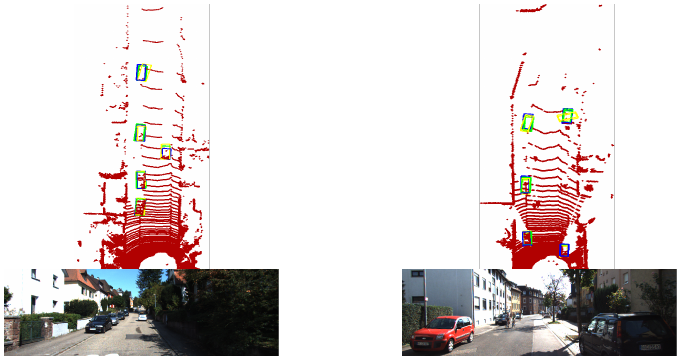
Figure 8. The qualitative results for orientation error. For better visualization, we put the results of the original network and proposed adaptive network together. The blue bounding boxes represent the ground truth box. The yellow bounding boxes represent the original result, and the green bounding boxes represent the results of the adaptive network. The result shows a typical direction error under a correct classification result. The direction of the green boxes is closer to the blue ground truth box, and the direction of the yellow bounding box is quite different from the blue bounding box. Our proposed adaptive network can improve the orientation accuracy.